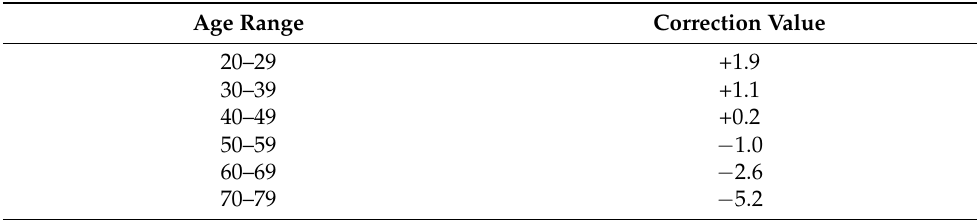
Table 10. Correction grid for age on execution times.